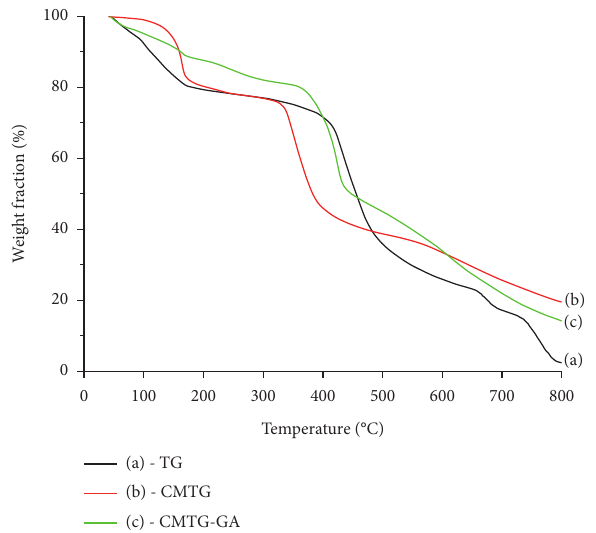
Figure 5: TGA curves of TG (a), CMTG (b), and CMTG-GA (c).